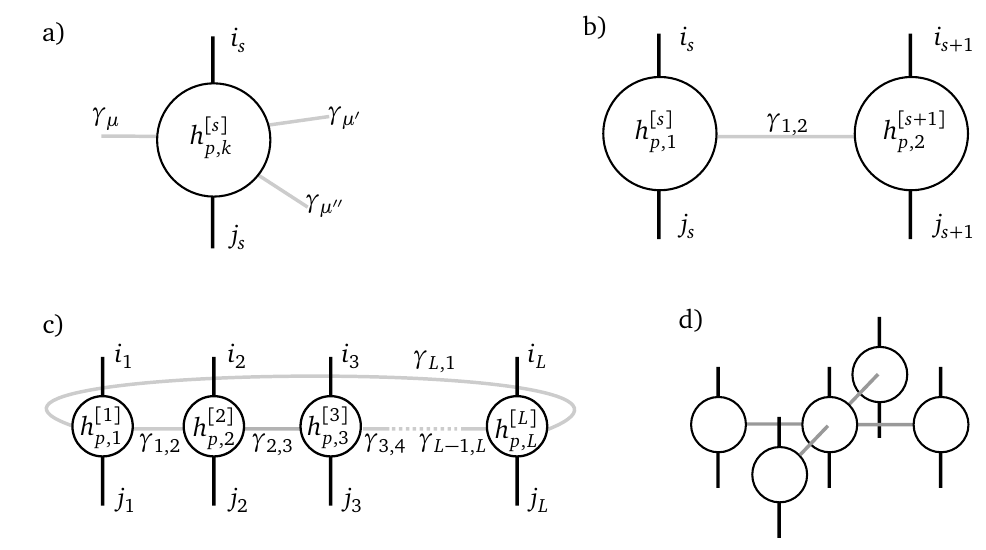
Figure 35: The TPO interaction terms H which sum up to the full Hamiltonian. (a) p [ s ] Each interaction p is composed of local operators h where [ s ] stands for the TN p , k physical link (or site) at which it is applied. The index k enumerates the TPO operators from k = 1... K , with K being the TPO operator length (in general different from the p p interaction range), and p distinguishes different interactions in the full Hamiltonian. Any two TPO operators k , k (cid:48) can be interconnected by a TPO link µ = ( k , k (cid:48) ) , drawn in gray, but efficiency mandates to keep their overall dimension small. (b)-(d) Examples of interactions: (b) a nearest-neighbor product interaction (such as the Heisenberg Hamiltonian), (c) a global TPO and (d) a possible interaction of a two-dimensional model, where the center-tensor has however four TPO